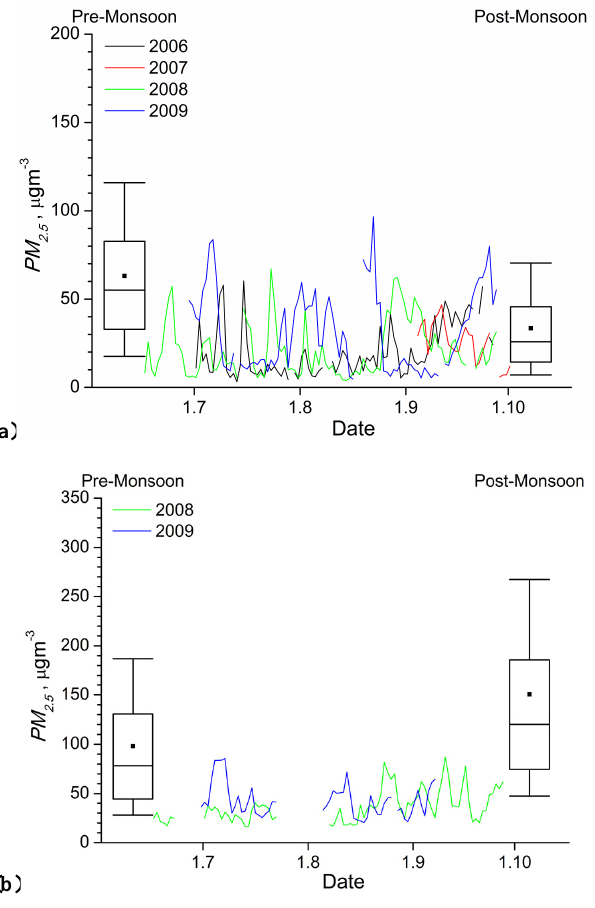
Fig. 8. PM 10 mass. (a) Mukteshwar (b) Gual Pahari. Lines are 24h running averages from the monsoon season, box plots denote the pre- and post-monsoon seasonal values of 10%-ile, 25%-ile, median (line), average (dot), 75%-ile, and 90%-ile. Concentrations are in STP